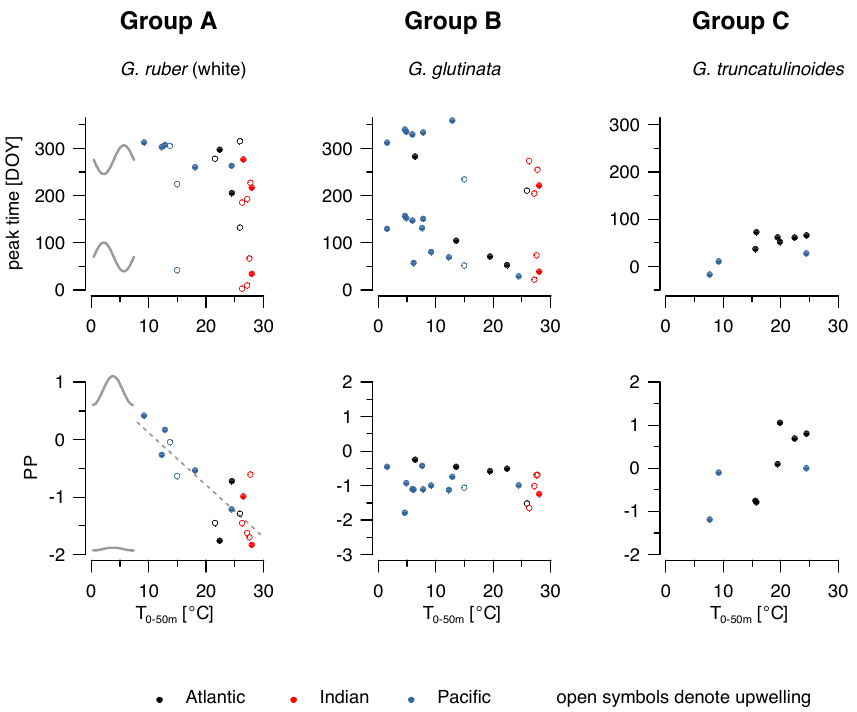
Figure 5. Three modes of seasonality: examples of each group; for all species see Fig. S6. Peak timing (day of year (DOY) on NH scale) and peak prominence (PP) vs. mean annual temperature between 0 and 50m. Group A: warm-water, symbiont-bearing species. Group B: temperate and cold-water species. Group C: deep dwellers. The grey solid curves in A illustrate the peak timing and prominence and the dashed grey line highlights the linear relation between PP and temperature (PP’). Note that peak timing represents circular data and that for G. truncatulinoides peak timing close to DOY 365 has been plotted as a negative value to highlight the